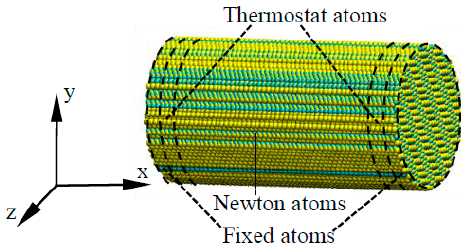
Figure 3. Molecular dynamics (MD) model for tension and compression tests.